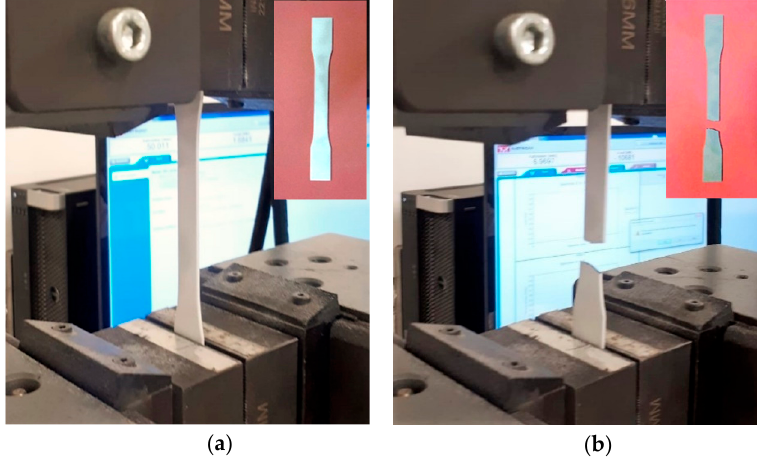
Figure 2. A dog-bone shaped MJF nylon 3D-printed nylon specimen; before ( a ), and after ( b ) tensile test.